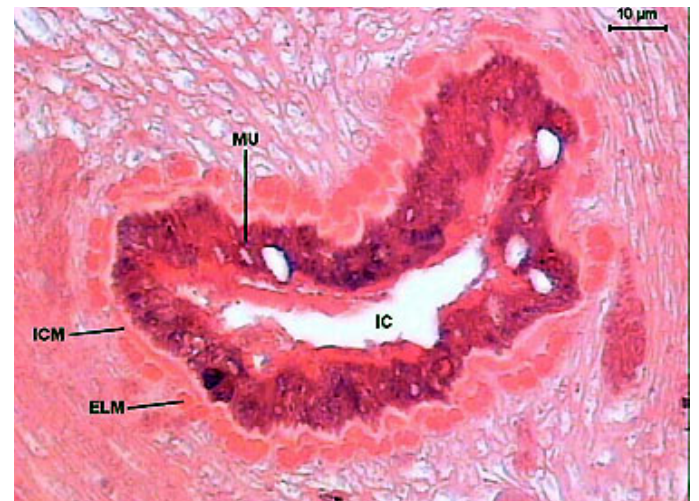
Figure 10. Transversal section of the Sticholecitha serpentis Intestinal caecum. IC – intestinal caecum lumen, MU – mucosa, ICM – internal circular musculature, ELM – external longitudinal musculature. HE.